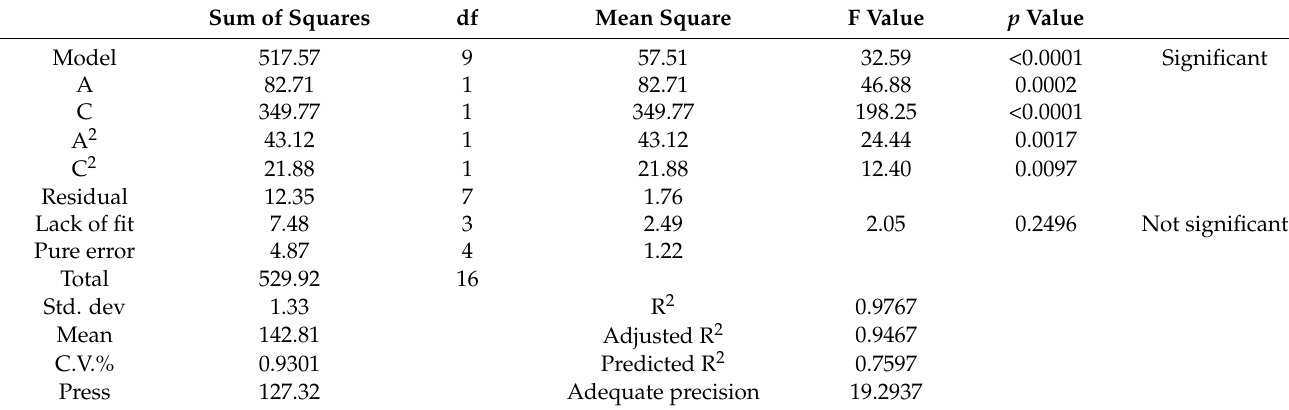
Table 7. Analysis of variance of the contact angle.